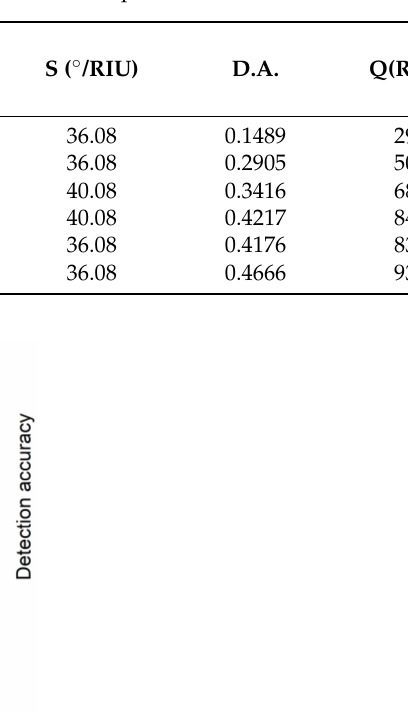
Table 3. Performance of the SPR sensor at different chemical potentials.